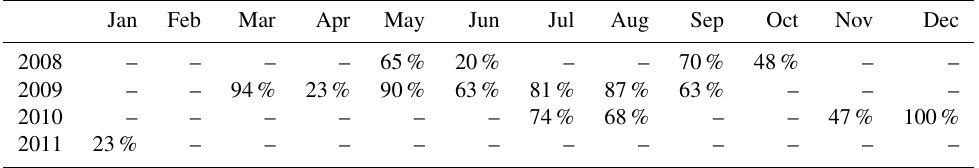
Table 2. For months when AMS data were available, percentages indicate the fraction of days with at least one data point. Jan Feb Mar Apr May